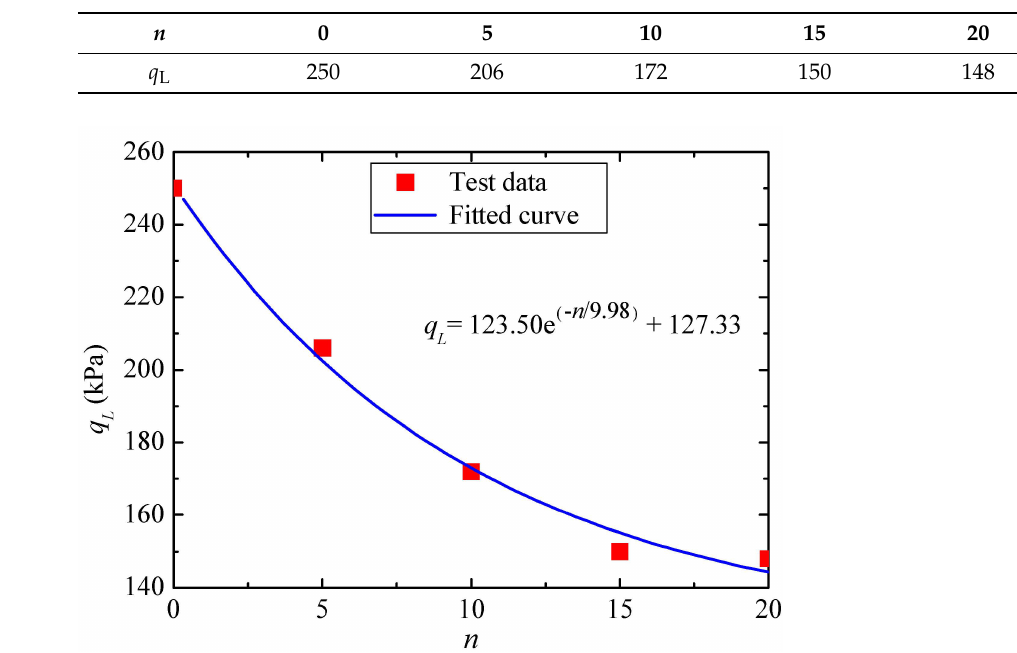
Figure 10. Creep isochronous curve after different dry-wet cycles. ( a ) n = 0, ( b ) n = 5, ( c ) n = 10, ( d ) n = 15, ( e ) n = 20. Table 3. Long-term strength after different dry-wet cycles (qL).